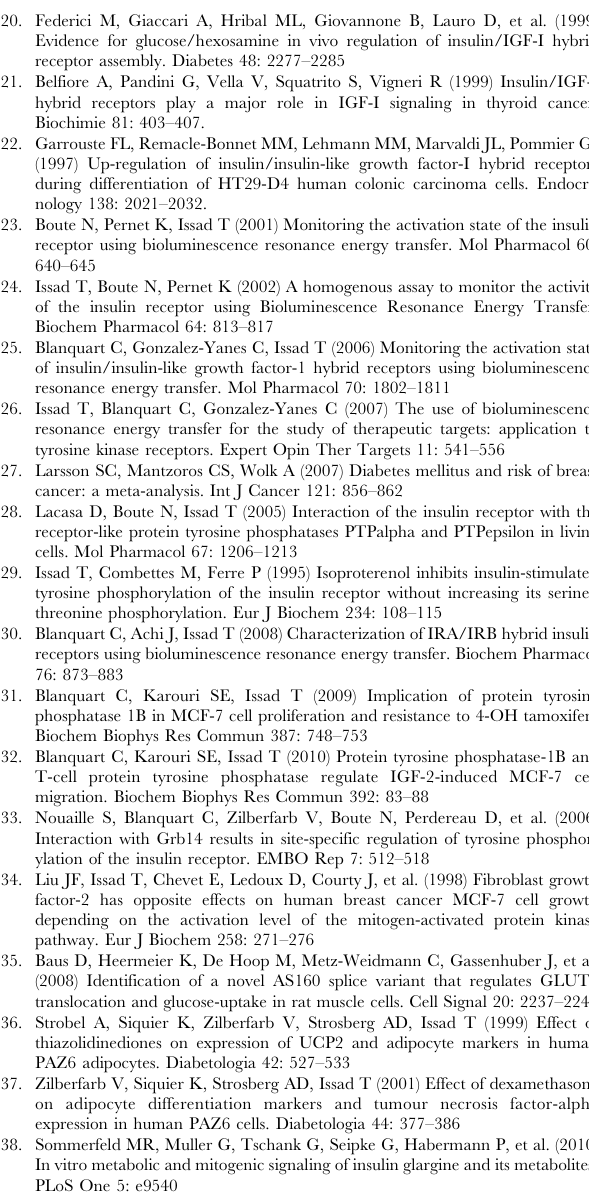
Figure S2 Validation of the method used for detection of IR/IGF1R hybrids. Partially purified receptors prepared from HEK-293 cells transfected as described in Fig. 1 were used to establish the specificity of the immunoprecipitation and immuno- blotting experiments. (A) WGL eluates were submitted to SDS- PAGE followed by immunoblotting (IB) using anti-IR (Santa Cruz C19) or anti-IGF1R antibodies (Santa Cruz C-20). (B) Luciferase and YFP-tagged IR, IGF1R and hybrid receptors were immuno- precipitated (IP) using an anti-IR antibody (CT1) immobilized on sepharose beads, submitted to SDS-PAGE followed by immuno- blotting using anti-IGF1R (Santa Cruz C-20) and anti-IR (Santa Cruz C-19) antibodies. After immunoprecipitation with